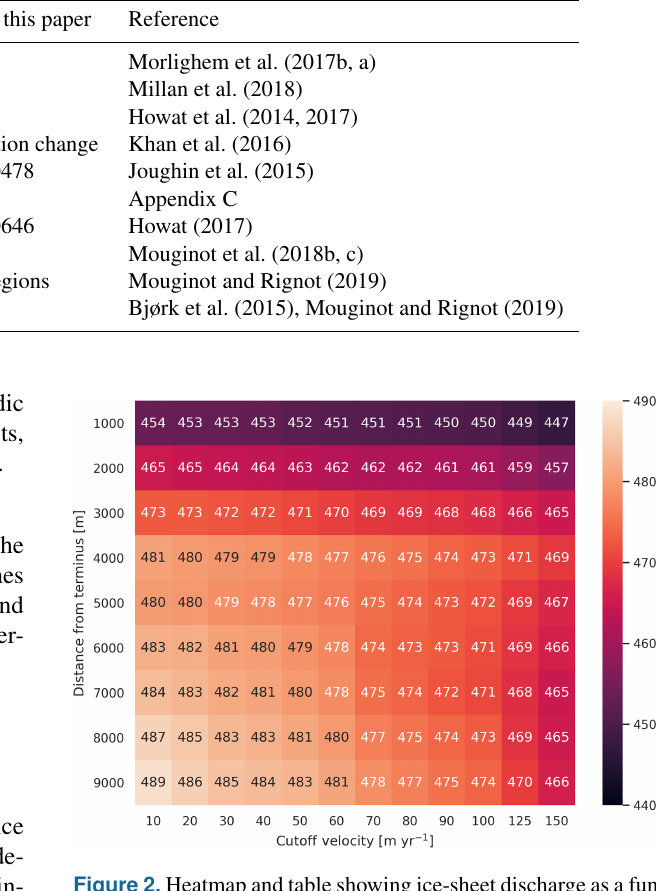
Figure 2. Heatmap and table showing ice-sheet discharge as a func- tion of gate buffer distance and ice speed cutoff. The colors of the numbers change for